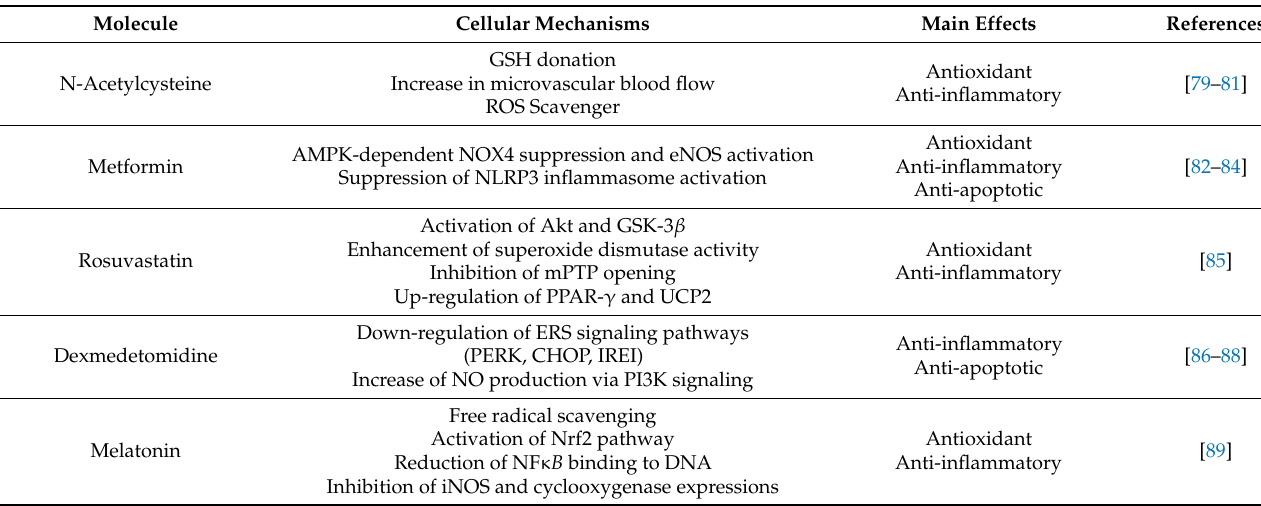
Table 2. Synthetic